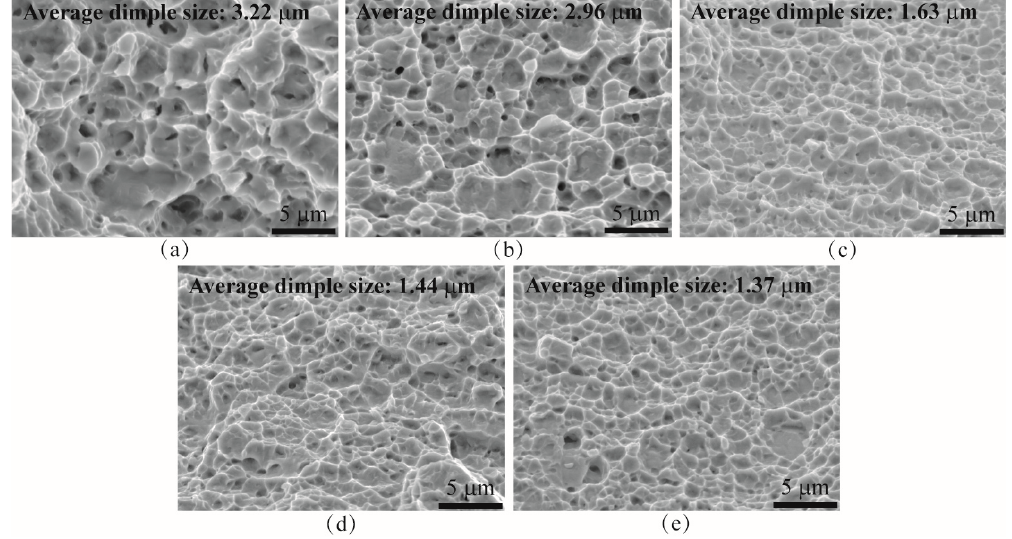
Figure 9. SEM images of the fracture surfaces for the tensile tests at various strain rates: ( a ) 0.0006/s; ( b ) 0.05/s; ( c ) 1.2/s; ( d ) 3.6/s; ( e ) 56/s.